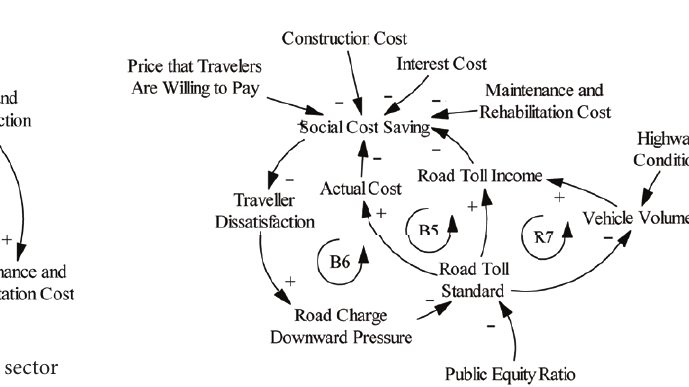
Figure 4. Causal loop diagram for consumer